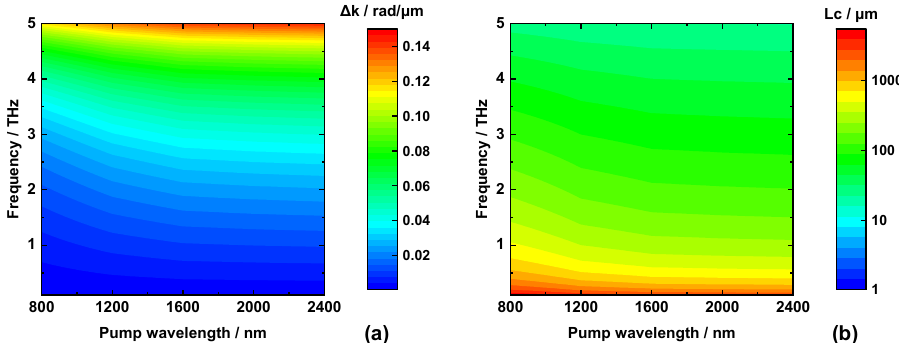
Figure 7. Pump-wavelength-dependent wave vector mismatch ∆ k ( a ) and coherent length L c ( b ) of OR in ZnSe.